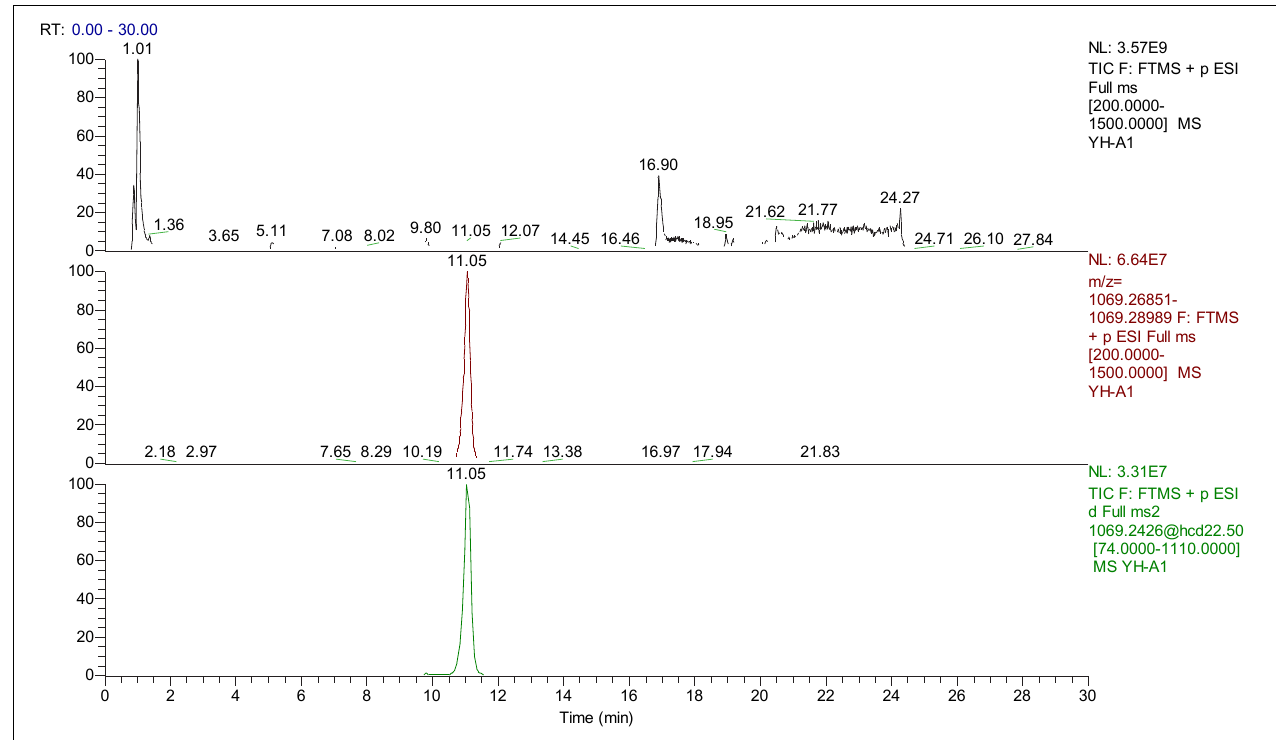
FIGURE 2 | The HPLC-ESI-MS/MS of peonidin 3-caffeoyl-p-hydroxybenzoyl-sophoroside-5-glucoside. Upper chromatograms: Total ion chromatogram (TIC); Middle chromatograms: Extracted Ion Chromatogram (EIC); Bottom chromatograms: Secondary fragment diagram.